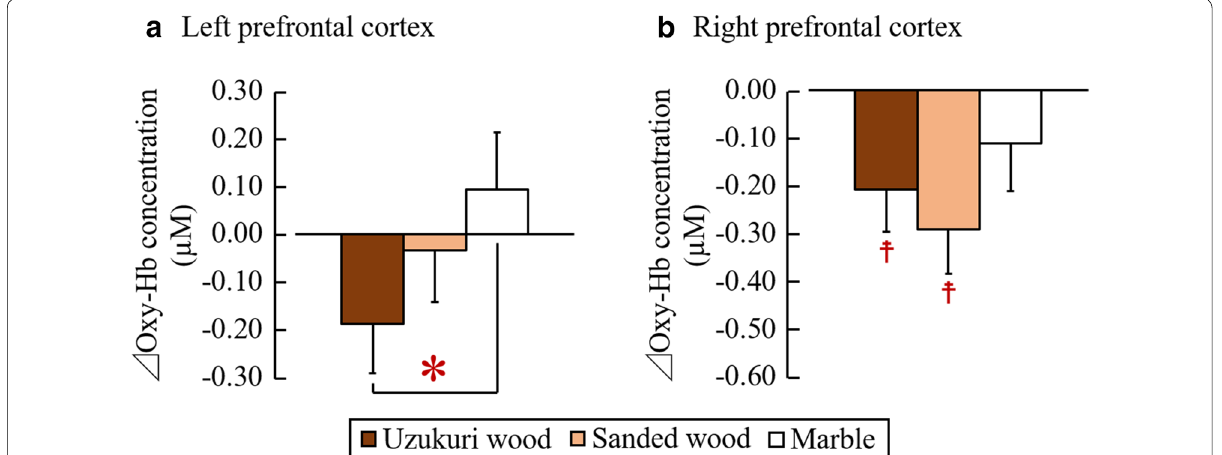
Fig. 5 Overall mean for the left and right prefrontal cortex activities during sole of the feet contact with the materials. a Oxy-Hb concentrations in the left prefrontal cortex. n 27, mean SE, * p < 0.05 (brushed wood vs. marble) as determined using a paired t-test with Holm correction. b = ± Oxy-Hb concentrations in the right prefrontal cortex. n